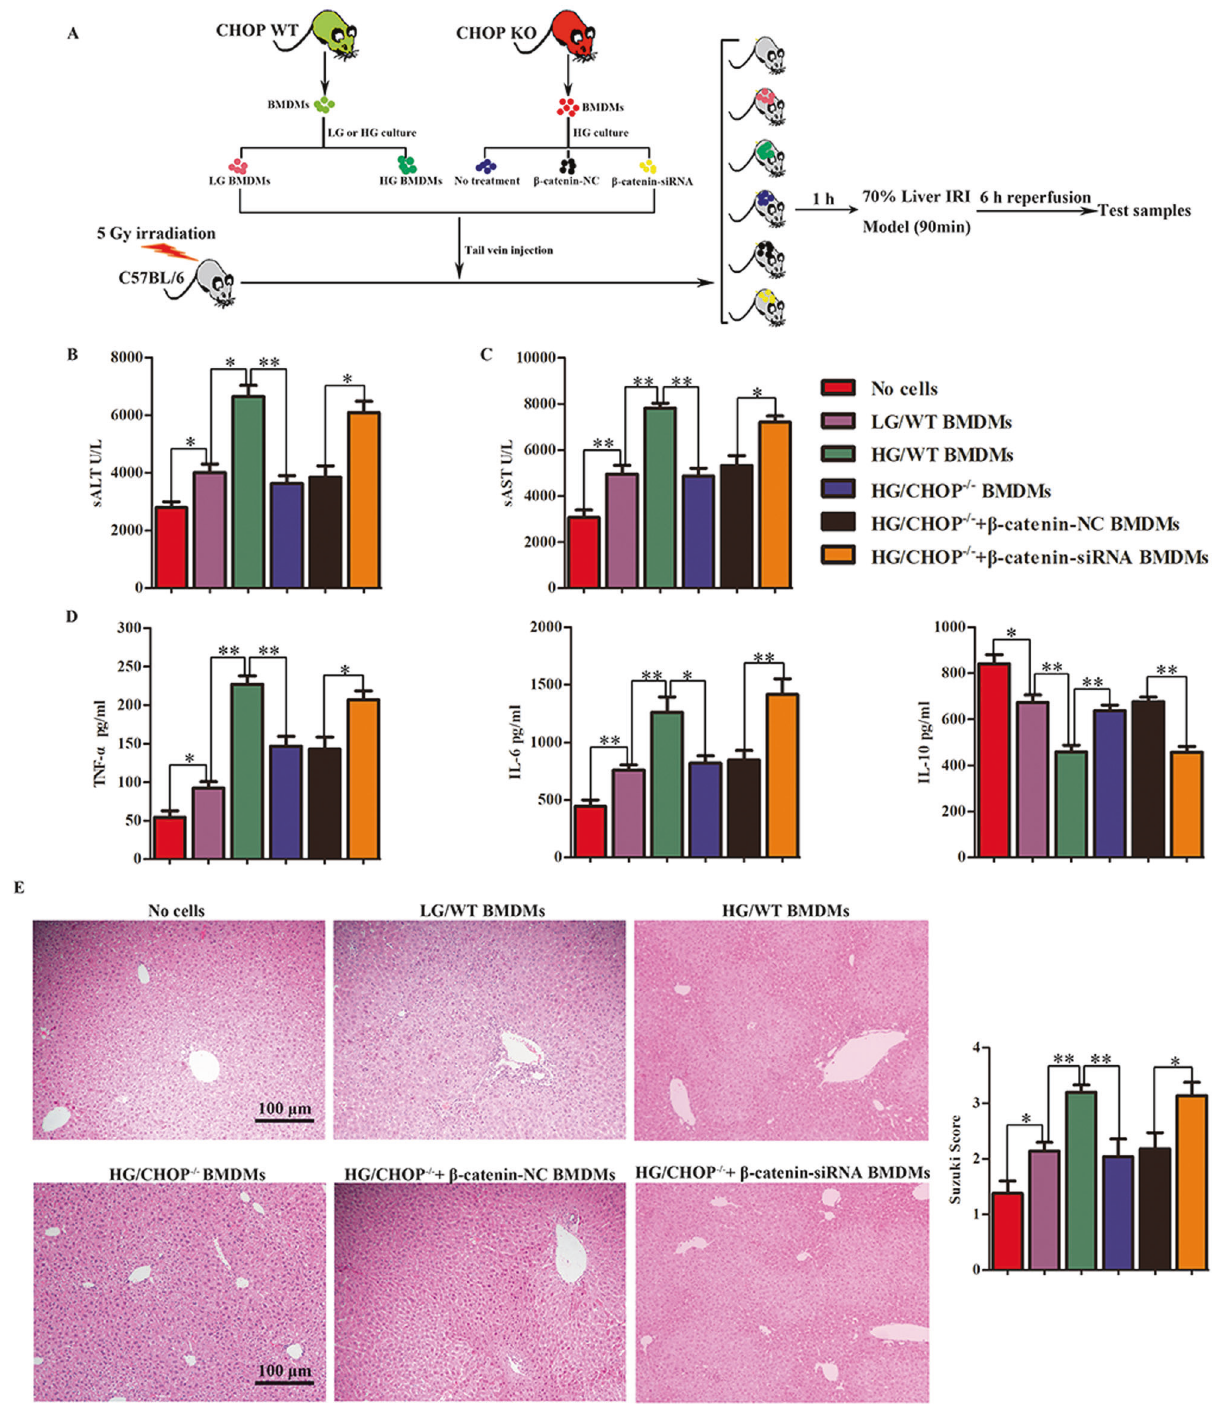
Fig. 8 Administration of HG-cultured macrophages exacerbated hepatic IRI by ATF6 – CHOP axis-mediated β -catenin. A Flow chart of administration of HG-cultured macrophages into mice. B , C Liver function was evaluated by sALT and sAST level ( n = 6). * P < 0.05, ** P < 0.01. D In fl ammatory cytokine levels in serum in different groups were determined by ELISA. E Histopathologic analysis of livers harvested 6 h after 90 min of liver ischemia, and severity elevation of liver injury was judged according to Suzuki ’ s histological grading. * P < 0.05, ** P < 0.01.